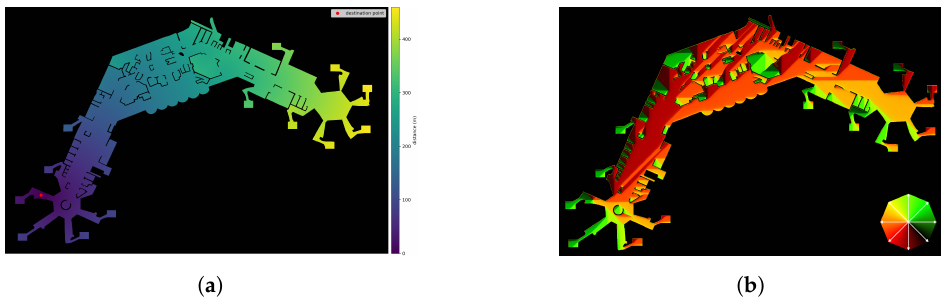
Figure 3. Exemplary visualisation of distance map φ dist and directions G dir , the associated desti- nation point is located in the lower left in both cases. ( a ) Colour-coded display of a distance map φ dist . ( b ) Colour-coded display of directions G dir , mapping of directions to colours is shown in the lower right.